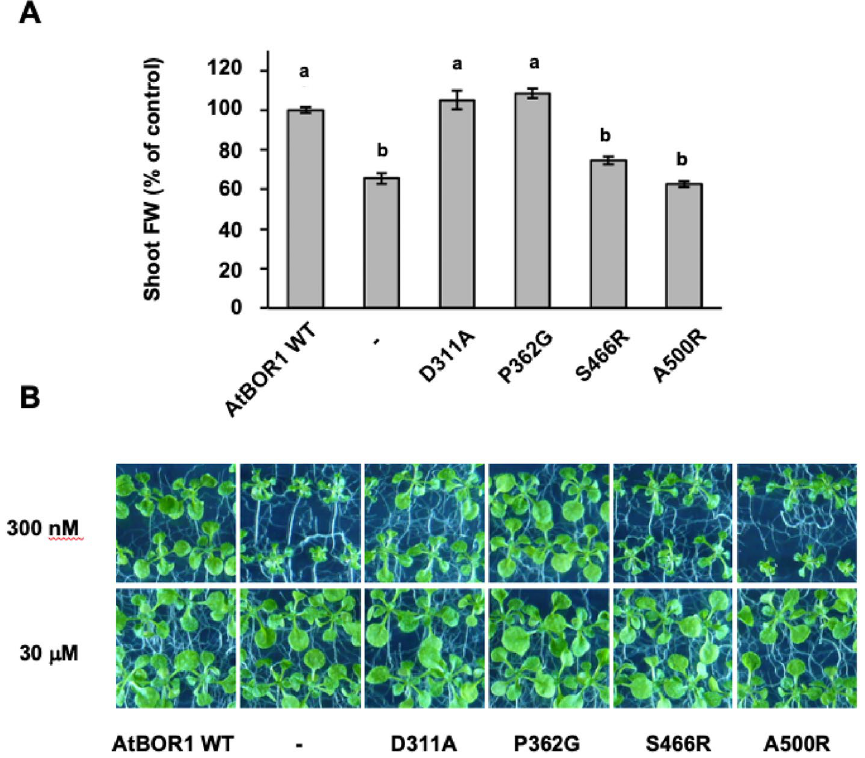
Figure 6. Phenotypes of AtBOR1 variant plants grown in vitro. ( A ) Comparison of the fresh weight of the different AtBOR1 variant plants grown on plates containing 300 nM boron, a , p < 0.01 compared to the negative control of the bor1-3 KO plants, b , p < 0.01 compared to WT AtBOR1 (ANOVA followed by Tukey’s test). Data is expressed relative to WT AtBOR1 and is mean ± S.E. of n = 12 plants. ( B ) Images of AtBOR1 variant plants grown on plants on 300 nM boron (upper panels) or 30 μM boron (lower panels). Data is representative of n = 2 independent